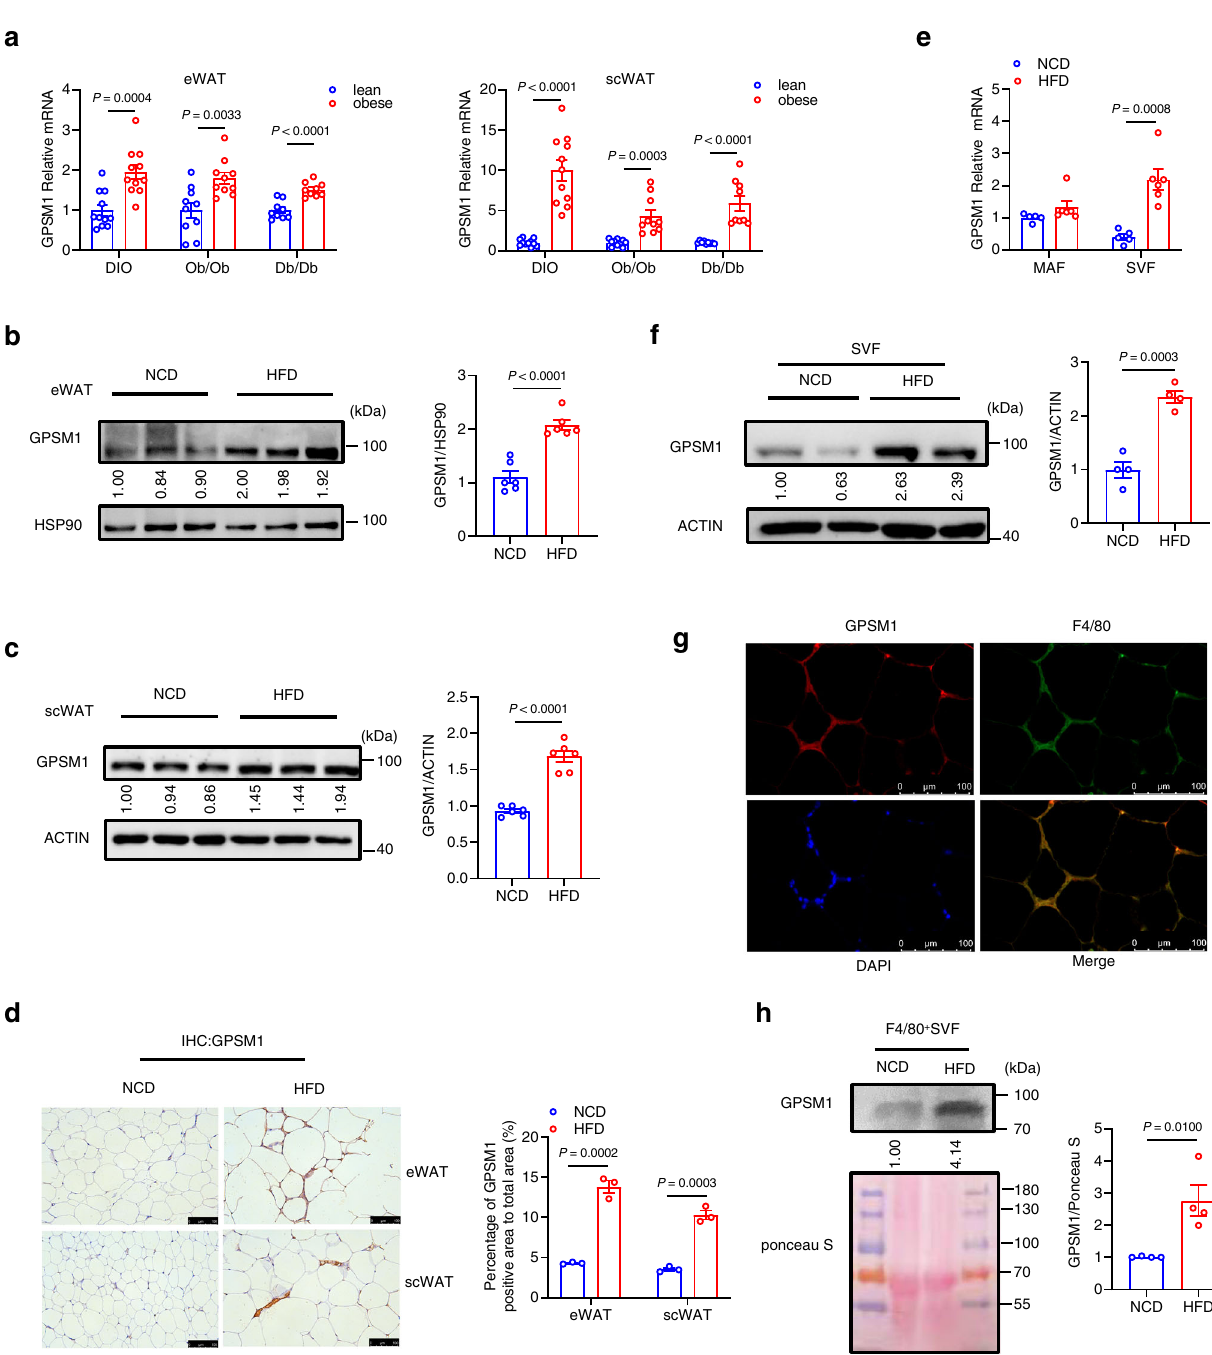
Fig. 1 | GPSM1 expression is upregulated in ATMs from obese mice. a RT-qPCR analysisof GPSM1 mRNAexpressioninepididymalWAT(eWAT)and subcutaneous WAT(scWAT)fromlean(blue)orobese(red)mice.ForDIO,WTmalemicewerefed normal chow diet (NCD) ( n =11 biologically independent sample) or high-fat diet (HFD) ( n =11 biologically independent sample) for 12 weeks. For genetic obesity, a group of WT ( n =10 biologically independent mice) and Ob/Ob ( n =10 biologically independent mice) and a separate group of WT ( n =9 biologically independent mice) and Db/Db ( n =9 biologically independent mice) were analyzed. Repre- sentativewesternblotanalysisandquanti fi cationofGPSM1expressionineWAT( b ) andscWAT( c )fromNCDandHFDmice(n=6biologicallyindependentsampleper group). d IHCstainingandquantitativeanalysisofGPSM1ineWATandscWATfrom NCD and HFD mice ( n =3 biologically independent sample per group). Scale bars, 100 μ m. e RT-qPCRanalysisof GPSM1 mRNAexpressioninstromalvascularfraction